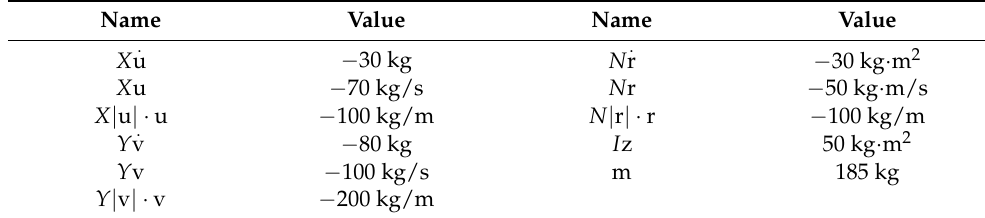
Table 1. Parameters related to dynamic constraints.